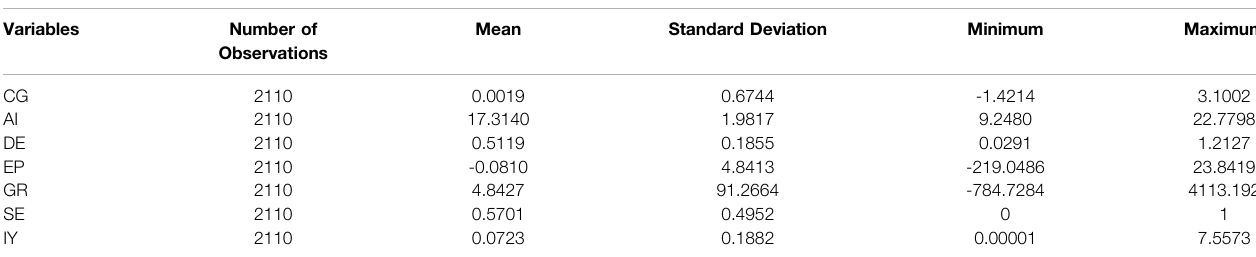
TABLE 2 | Descriptive statistics of basic